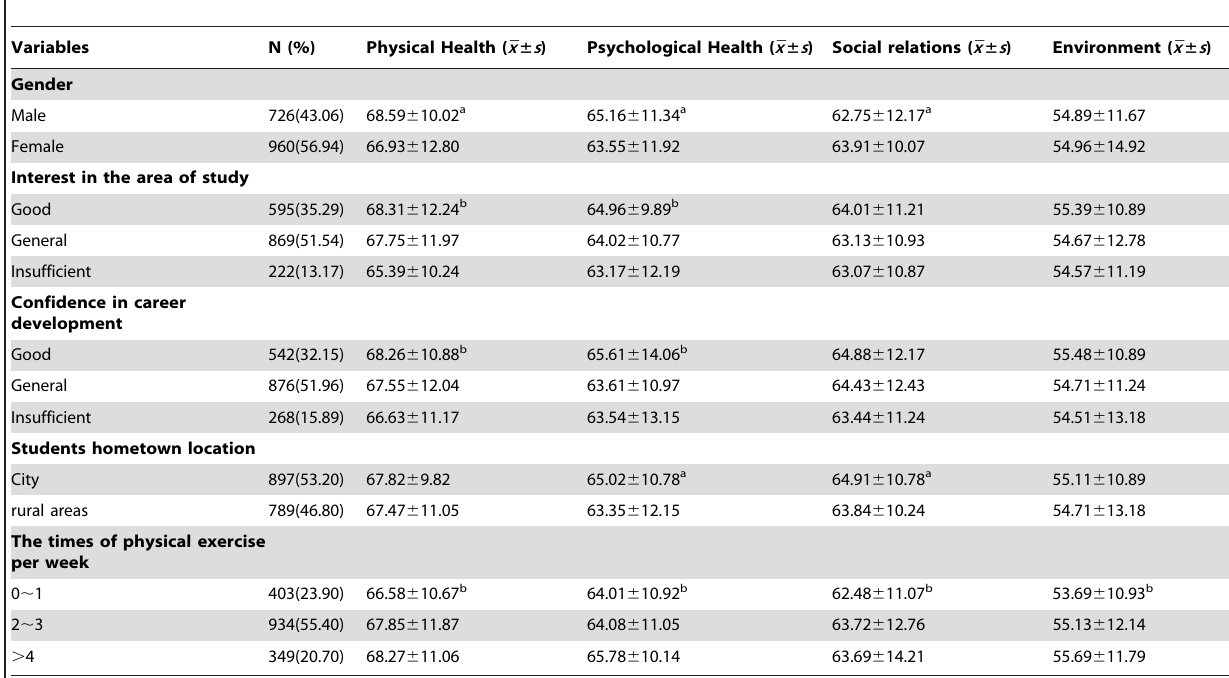
Table 5. Scores of medical students according to the impact factors of